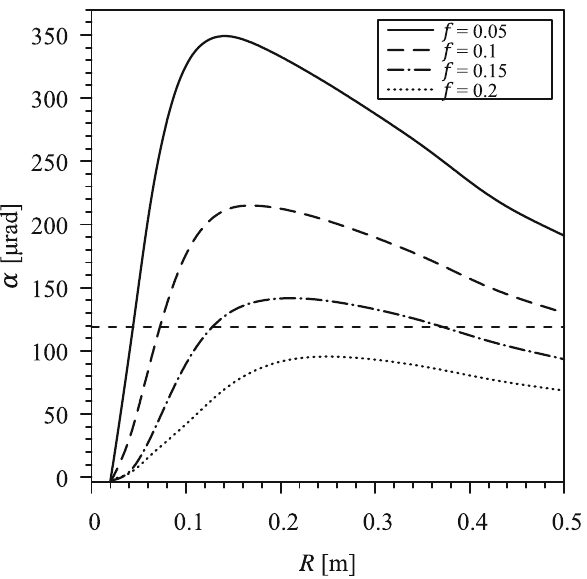
Fig. 3 Dependence of the maximum deflection angle of of antiprotons with a kinetic energy of 14 GeV on the bending radius of the crystal in case of planar channeling